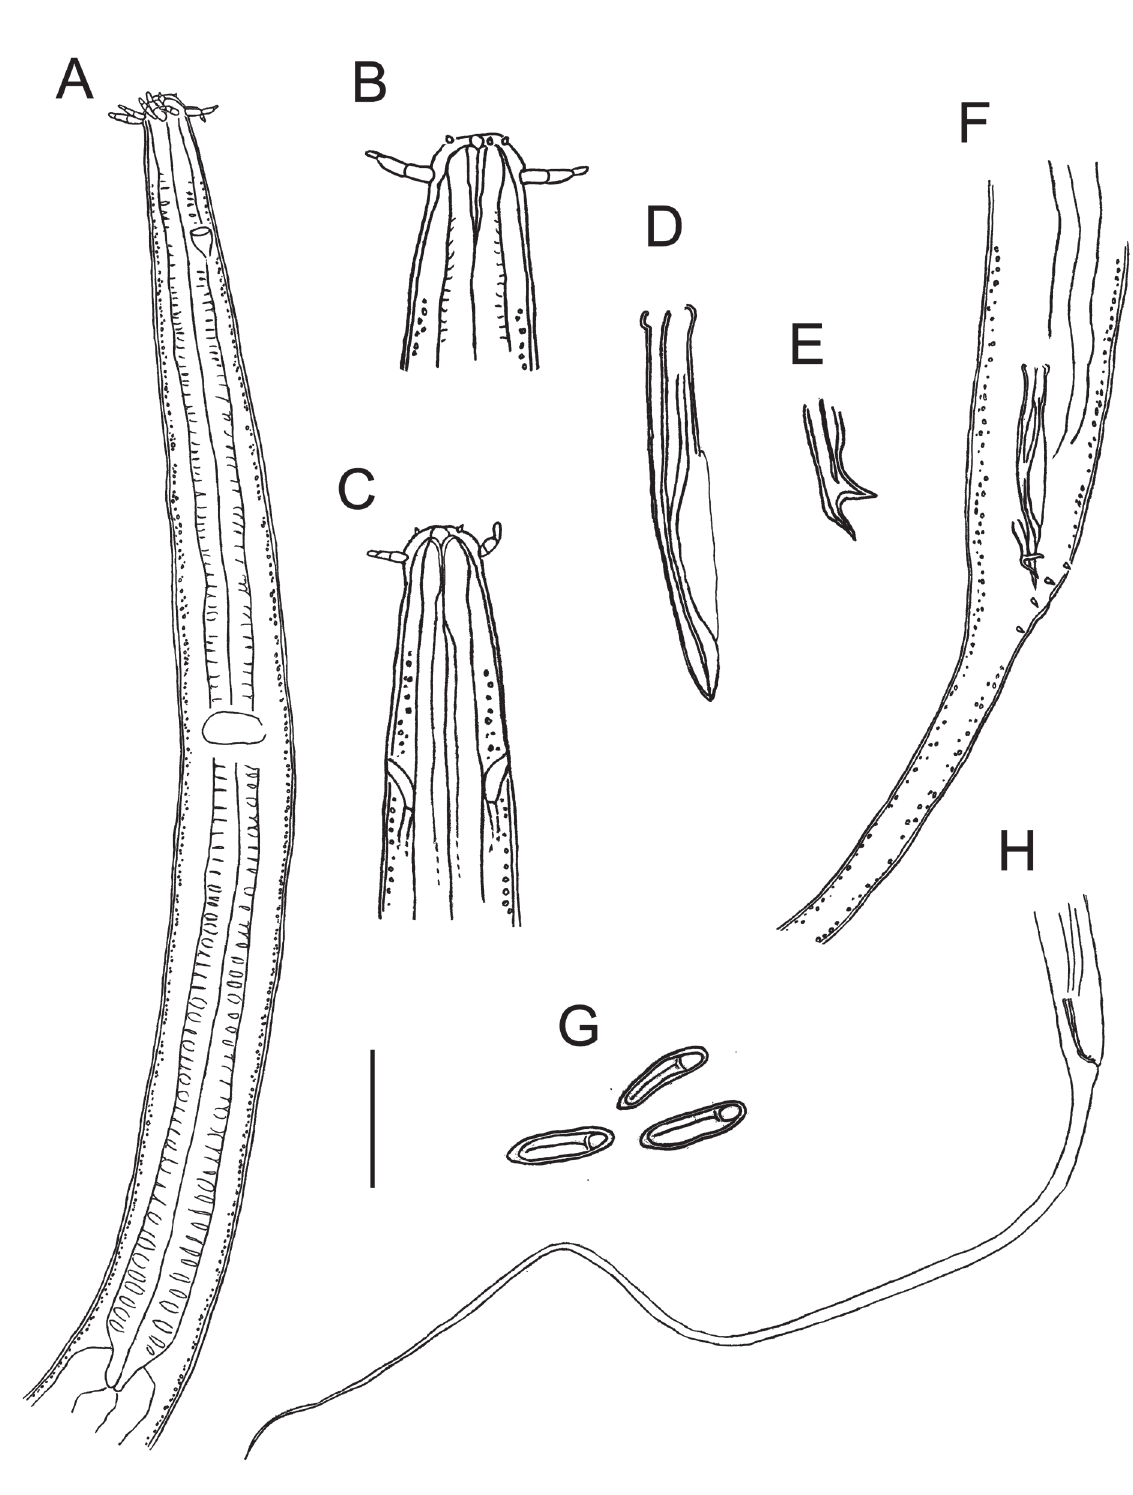
Fig. 3. Trefusialaimus idrisi sp. nov. A . Anterior body region of male. B . Head of male. C . Head of juvenile. D . Right spicule. E . Gubernaculum. F . Male copulatory apparatus. G . Mature sperm. H . Posterior body region of male. Scale bar: A = 40 µm; B-C, G = 20 µm; D-E = 14 µm; F = 28 µm; H = 75